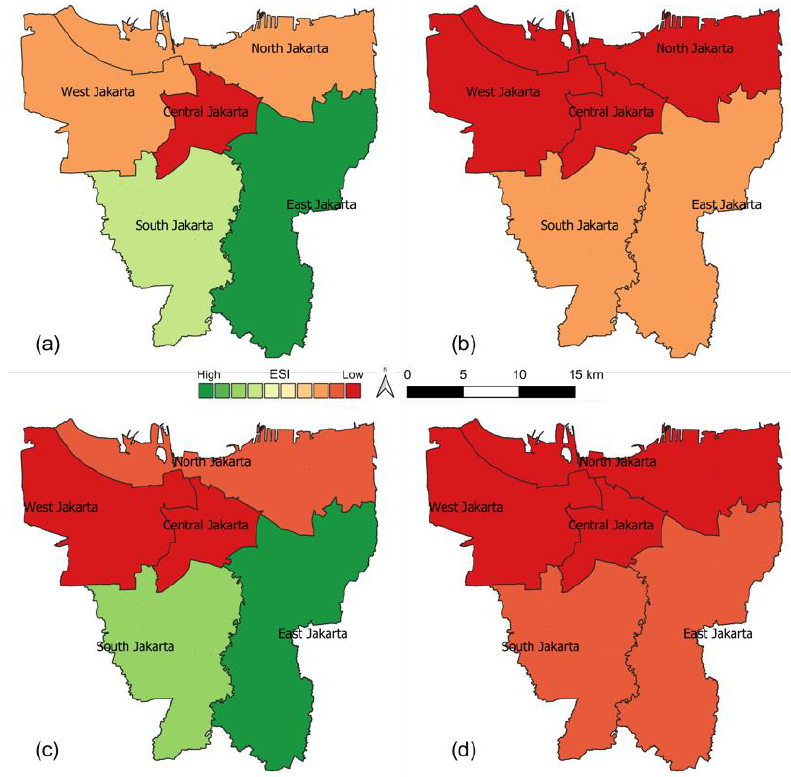
Figure 10. ESI for carbon sequestration in the year 1995 and 2014. ( a ) ESI in 1995 without LMA; ( b ) ESI in 2014 without LMA; ( c ) ESI in 1995 with LMA; and ( d ) ESI in 2014 with LMA. The different spatial patterns of the temperature regulation indicate the influence of the landscape patterns of green spaces and bodies of water, as shown in Figure 11. It shows that the temperature regulation from the LMA-based estimation had a higher decrease rate compared to that from the area-based estimation. The impact of the landscape pattern changes on the temperature regulation was reflected in the LMA-based estimation that suggested the highest decrease rate in West Jakarta ( − 74.6%), followed by South Jakarta ( − 64.1%), East Jakarta ( − 61.1%), North Jakarta ( − 50.1%), and Central Jakarta ( − 23.7%). Moreover, the highest temperature regulation in 2014 was in East Jakarta, followed by North Jakarta, South Jakarta, West Jakarta, and Central Jakarta. On the other hand, the but the decrease rate was lower than that in the LMA-based estimation. For instance, the decrease rate of the temperature regulation with the area-based estimation in East Jakarta was − 44.7% lower than that from the LMA-based estimation. This decreased pattern was also observed in all